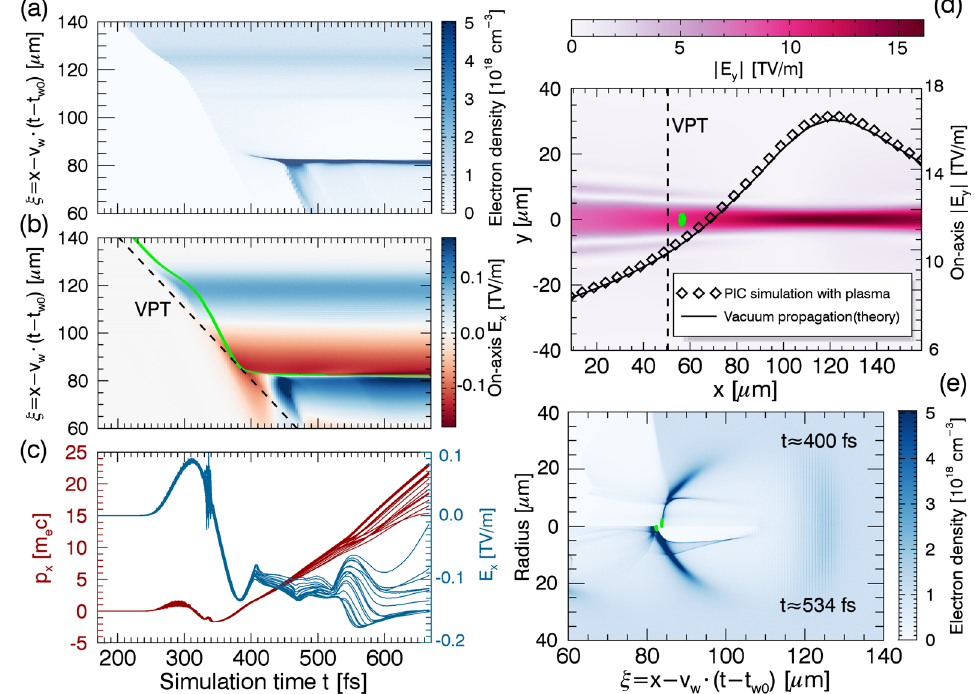
FIG. 1. 2D PIC simulation results. (a) The evolution of on-axis electron density, where ξ is the comoving coordinate. (b) Evolution of on-axis longitudinal electric field E . The green curves are the trajectories of 18 sample macroparticles. (c) Evolution of the longitudinal x momentums and experienced longitudinal electric fields of the sample macroparticles from (b). (d) The amplitude of injector pulse along its propagation. The theoretical curve is obtained from Eq. (1). The green dots represent the initial positions of all injected electrons. (e) Electron density distribution in the comoving coordinates ð ξ ; r Þ at different simulation times. The green dots are the positions of the sample macroparticles from